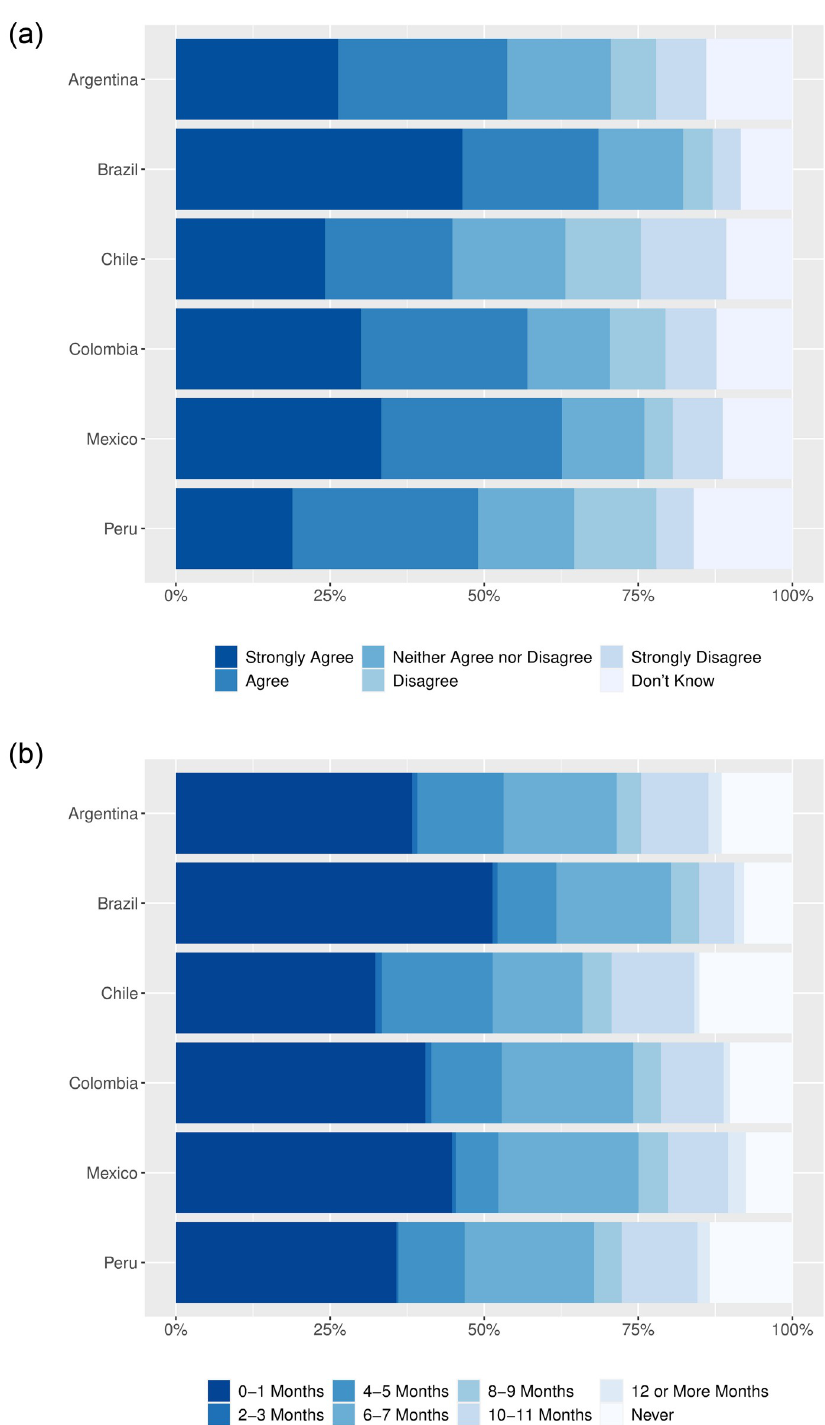
Fig 2. Distribution of vaccine willingness across countries (January 11–29, 2021). The questions for each figure were asked at the beginning of the survey of all participants. Observations are weighted to match the joint distribution over education, sex, region, and age category from the most recent census in each country (a) “If a vaccine were available to me now, I would get vaccinated.” (b) “If a vaccine were available to you now, how many months would you wait before getting